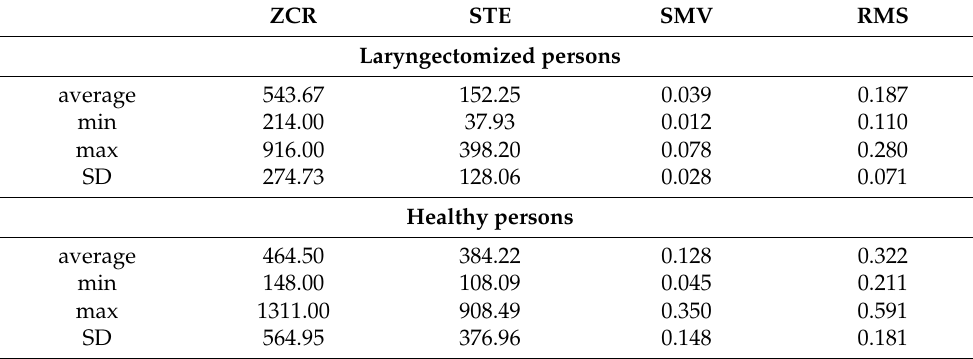
Table 3. The distribution of the values of the features: the second phonetic segments „cz”—the word “beczka”.